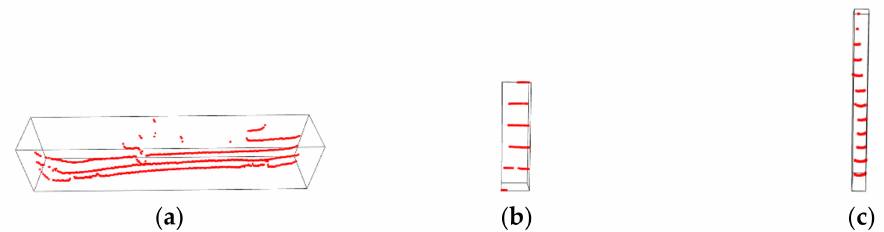
Figure 12. Using the axis-aligned bounding box (AABB) formed by the major part to represent a certain object. ( a ) AABB of car; ( b ) AABB of pedestrians; ( c ) AABB of tree